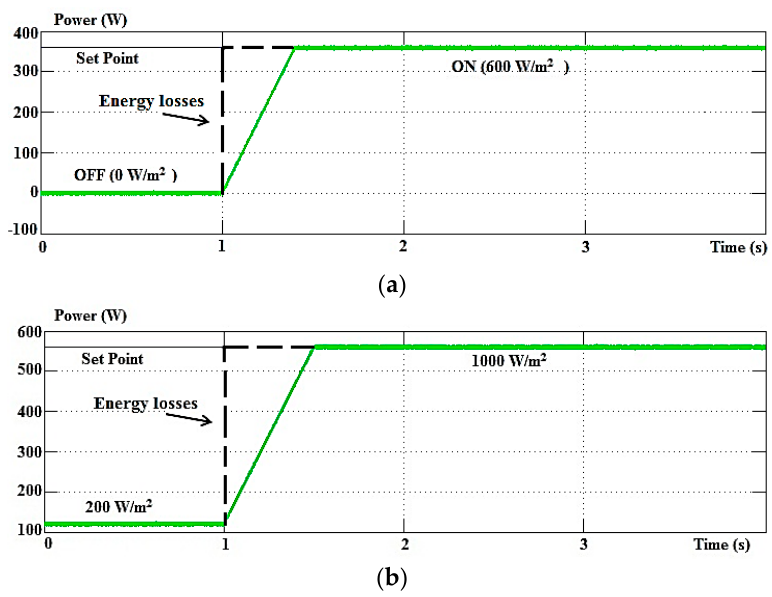
Figure 20. Energy loss analyses for experimental results of the self-charging with step size error cancellation DC link capacitor voltage control algorithm under ( a ) off–on and ( b ) change of irradiance operations.